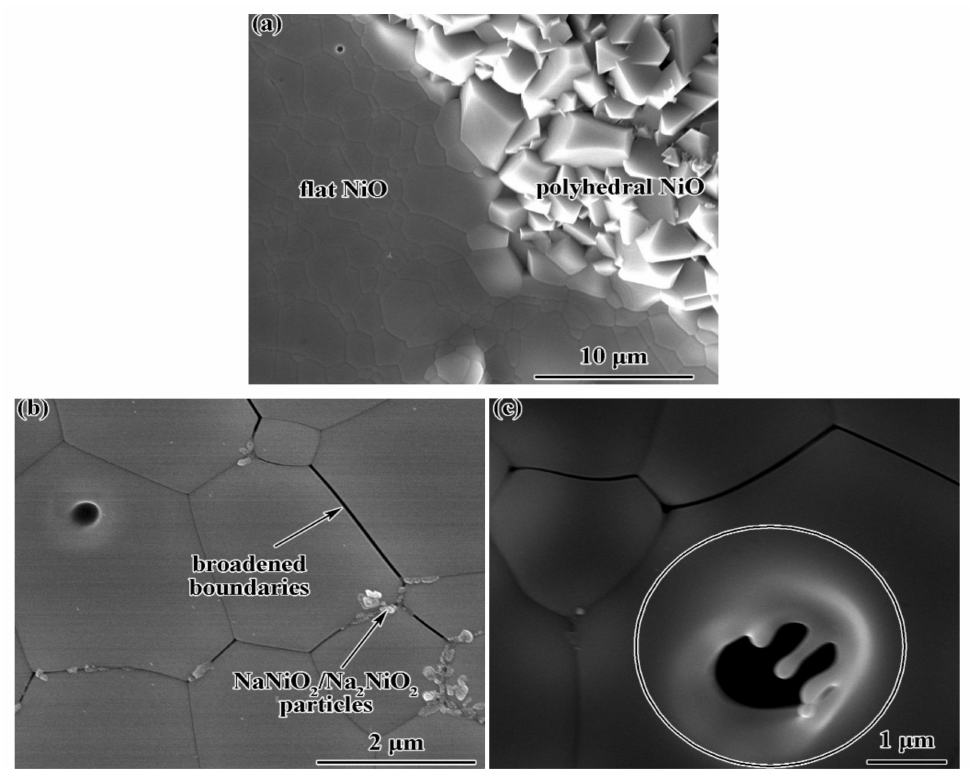
Figure 10. Morphologies of NiO on the gradient and preoxidised coatings after the hot corrosion test lasting 220 h: ( a ) 10,000 × ; ( b ) 50,000 × ; ( c ) 50,000 ×